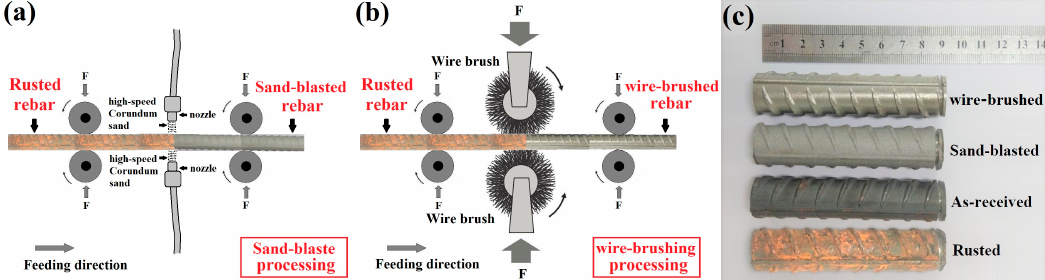
Figure 1. Schematic illustration of the sand blasting process ( a ) and the wire brushing process ( b ) of rebar and physical images of the rebar with different surface states ( c ).